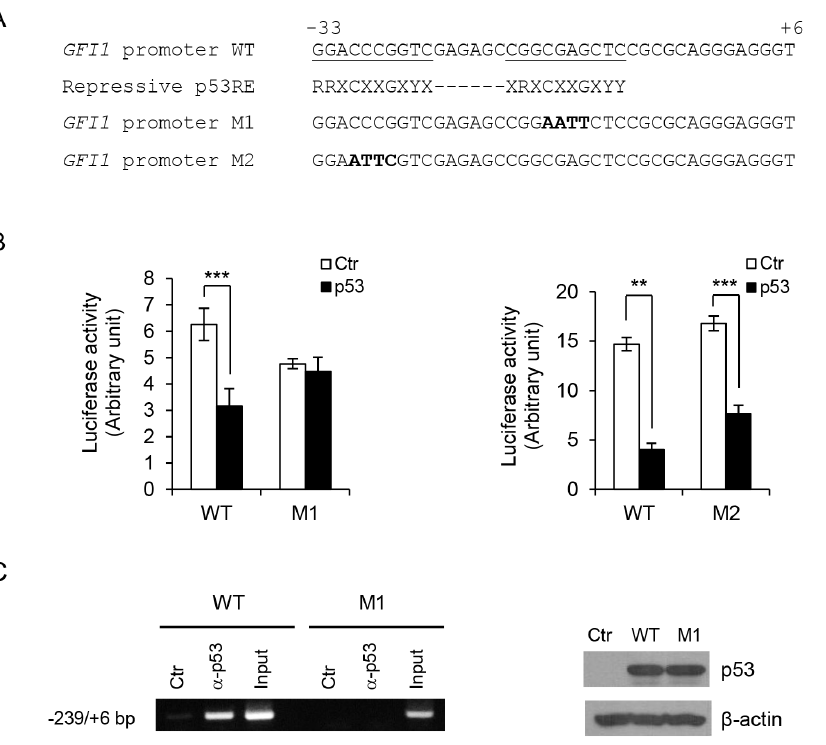
Figure 5. Identification of the repressive p53 RE in GFI1 core promoter. (A) Nucleotide sequences of wild type (WT) and mutated GFI1 core promoter fragments as compared with conserved repressive p53 RE. Potential p53 RE in GFI1 core promoter are underlined. Mutated nucleotides are in bold. (B) p53 2 / 2 HCT116 cells were transfected with WT or M1 GFI1 promoter ( 2 1933/ + 468 bp; left panel), or WT or M2 GFI1 promoter ( 2 460/ + 6 bp; right panel) luciferase reporter construct without or with p53. Luciferase activity was measured 36 hrs after transfection. (C) p53 2 / 2 HCT116 cells were transfected with pGL3-basic plasmid containing WT or M1 GFI1 promoter fragment ( 2 4840/ + 184 bp) along with p53. Binding of p53 to the GFI1 promoter fragments was examined by ChIP assays (left panel). Expression of p53 was confirmed by Western blot analysis (right panels).